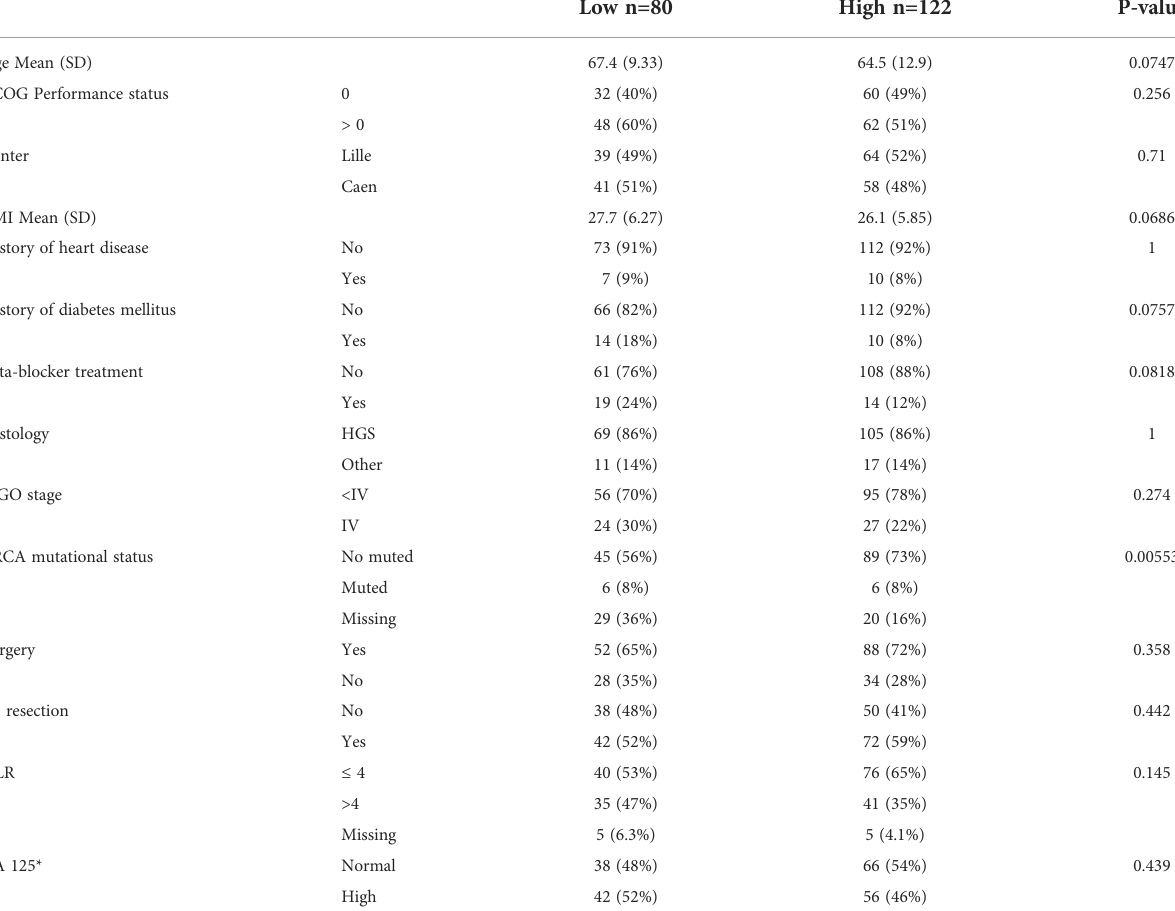
TABLE 2 Patient and tumor characteristics between low and high